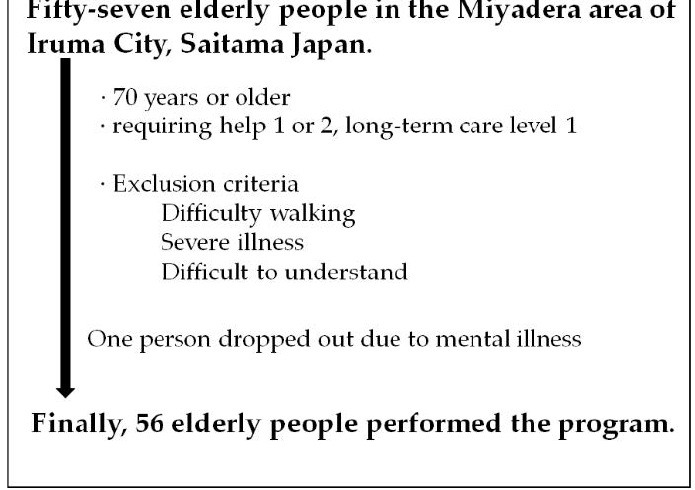
Figure 1. Eligibility of subject person.